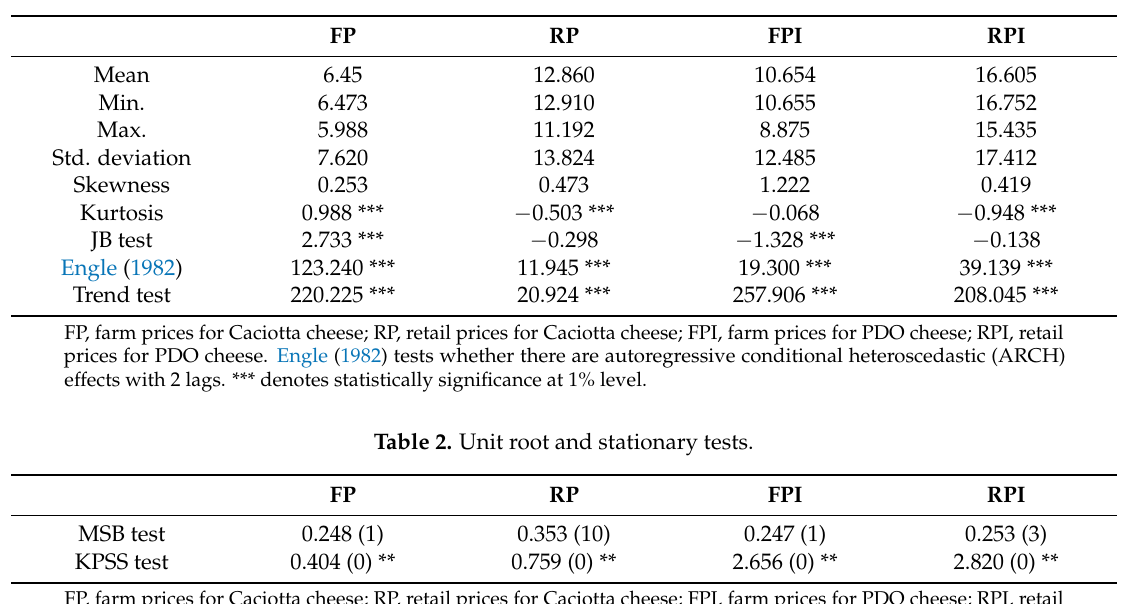
Table 1. Summary of descriptive statistics.